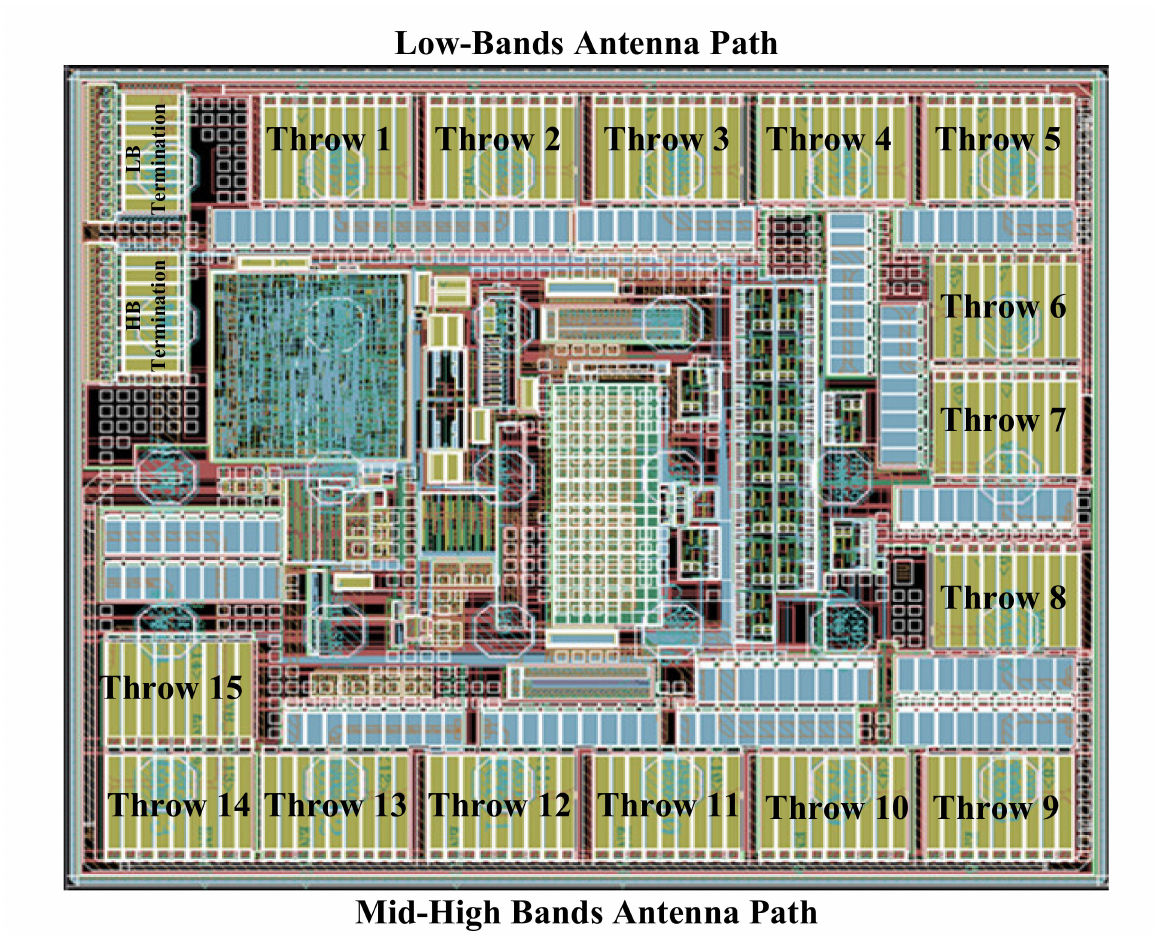
Figure 6. The top layout of the proposed module, illustrating the SP7T and SP8T RF switches and their corresponding terminations paths, TRM1 and TRM2,